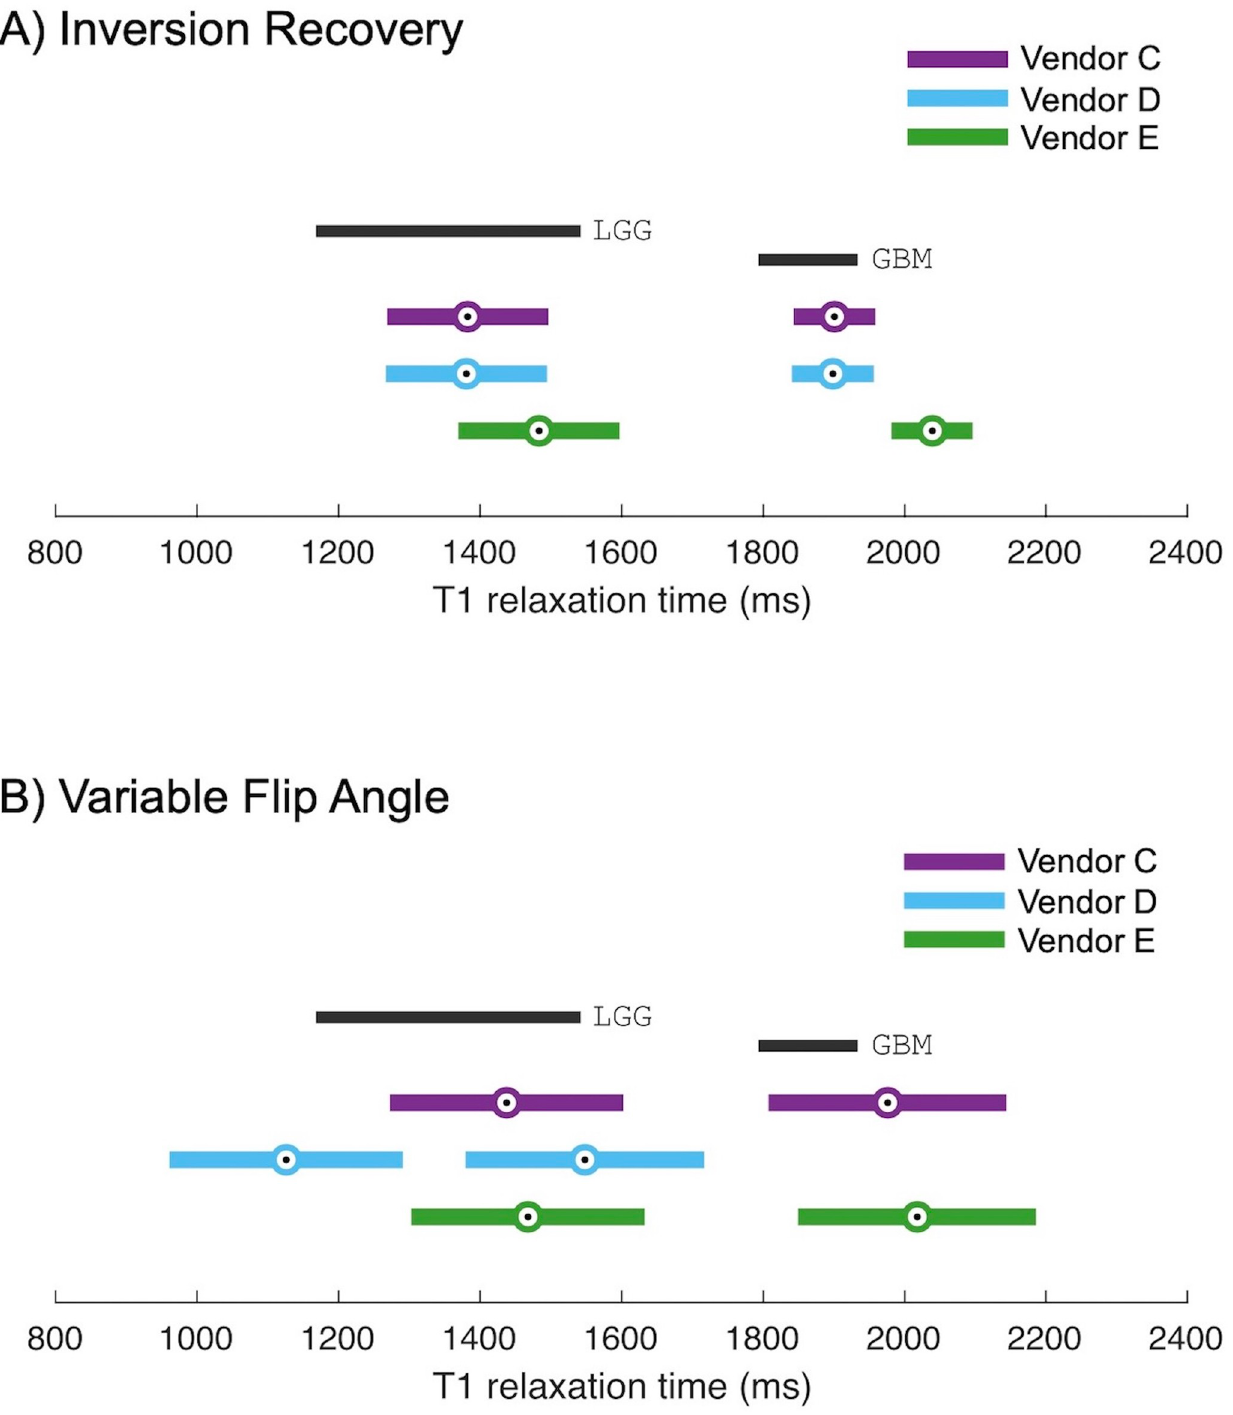
Fig 7. Impact of vendor differences in T1 measurement. Here, we have plotted the reported T 1 of low grade glioma and glioblastomas [8] and an estimate for each vendor system of the diagnostic range for low grade glioma and glioblastomas based on the bias and dispersion of that system. The challenge is to define a diagnostic criterion based on T 1 to distinguish low grade glioma from glioblastoma that would be suitable across vendor systems. If T 1 relaxation time is measured using IR (A), the overestimate of values by vendor E is small compared to the range of physiological values, and as a result, T 1 measured by IR could be a reliable measure across vendor systems. However, if the VFA method is used (B), the underestimate of T 1 on vendor D could inaccurately diagnose a glioblastoma as a low-grade glioma, an incorrect determination with serious impacts to patient management.